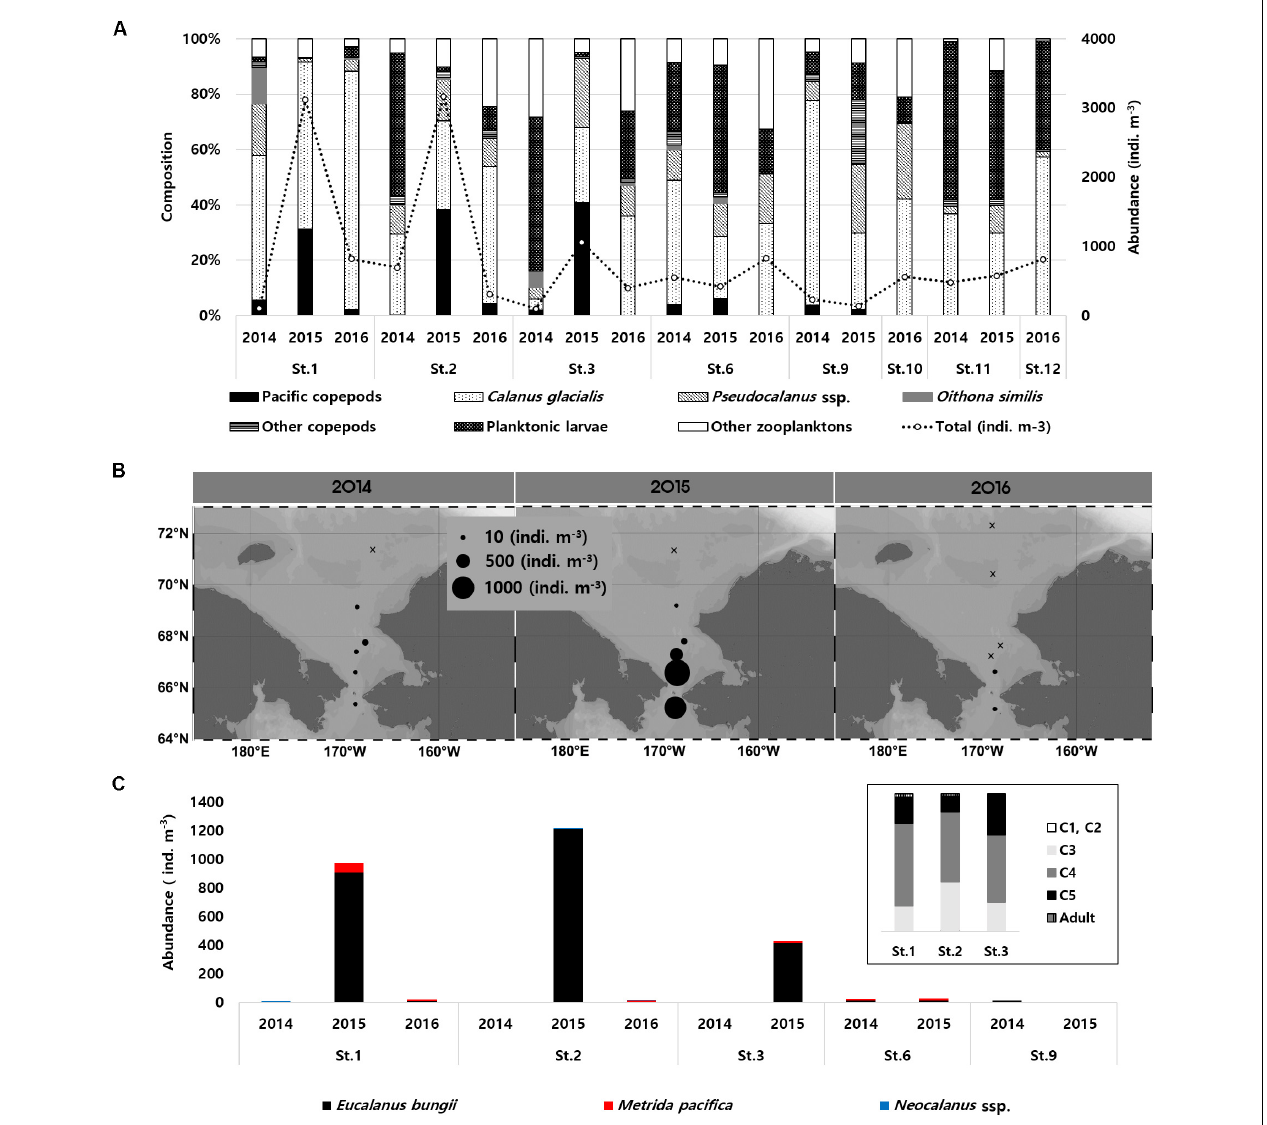
FIGURE 2 | (A) Composition of zooplankton and total abundance in summer for the Southern Chukchi Sea 2014–2016; (B) Proportional abundance plots (indiv. m − 3 ) of Pacific copepods in the Chukchi Sea ( Eucalanus bungii, Metridia pacifica , and Neocalanus spp. combined); (C) Composition of Pacific copepods in summer for the Southern Chukchi Sea